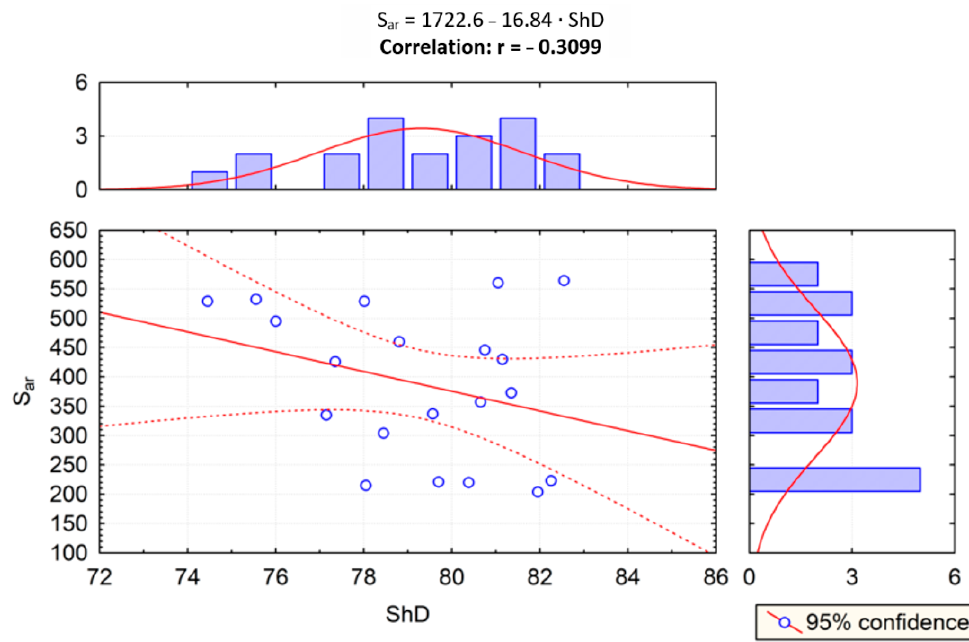
Figure 17. Dependence between cross-sectional area S ar and Shore hardness ShD (r—correlation).